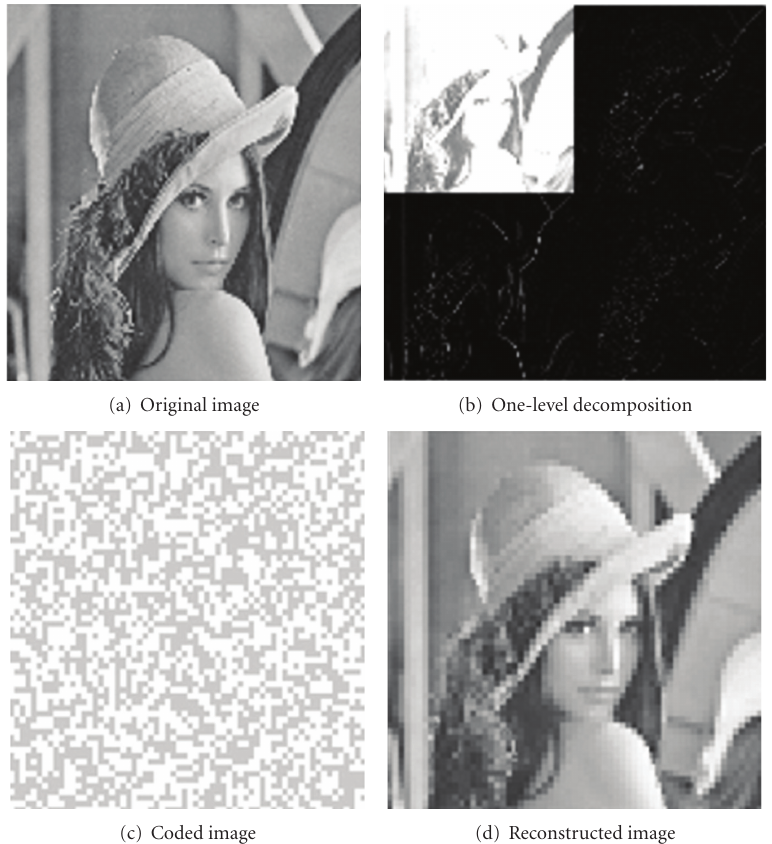
Figure 3: Test image 1 (Lena.PGM) when x (1) = 0 . 12345, α = 4, key1 = 1234567890223344, and key2 = 0987654321001122, Thr = 30, PSNR = 28 .